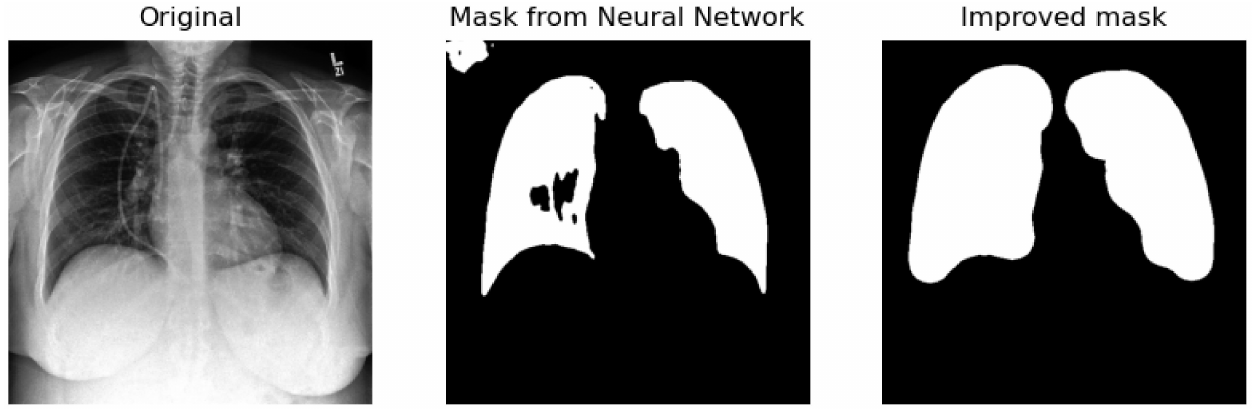
Figure 1. Sample lung segmentation on X-ray